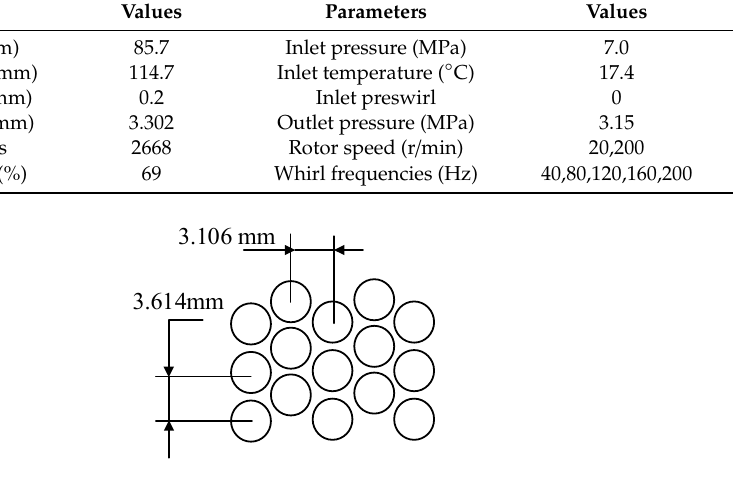
Figure 3. Distribution of seal holes in the stator surface.